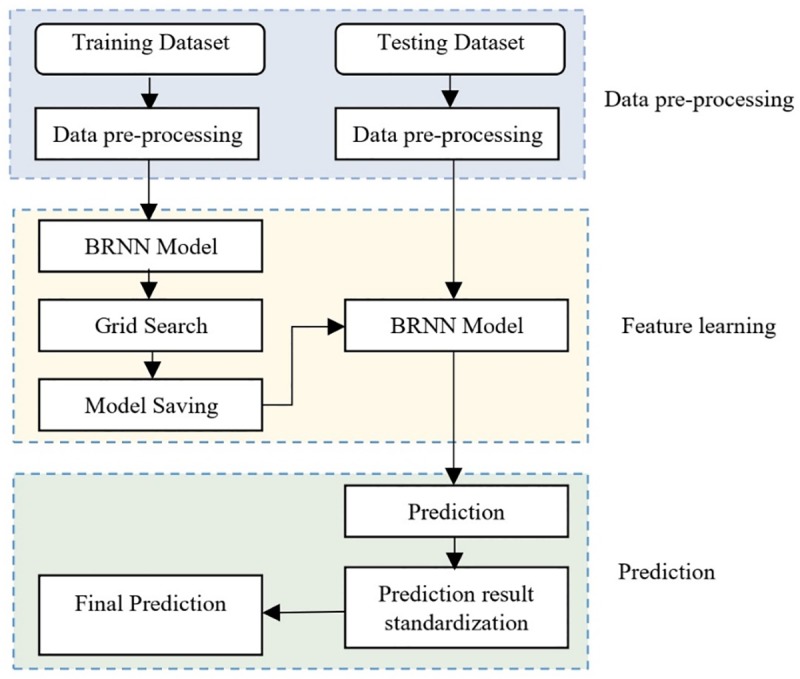
The BRNN structure.